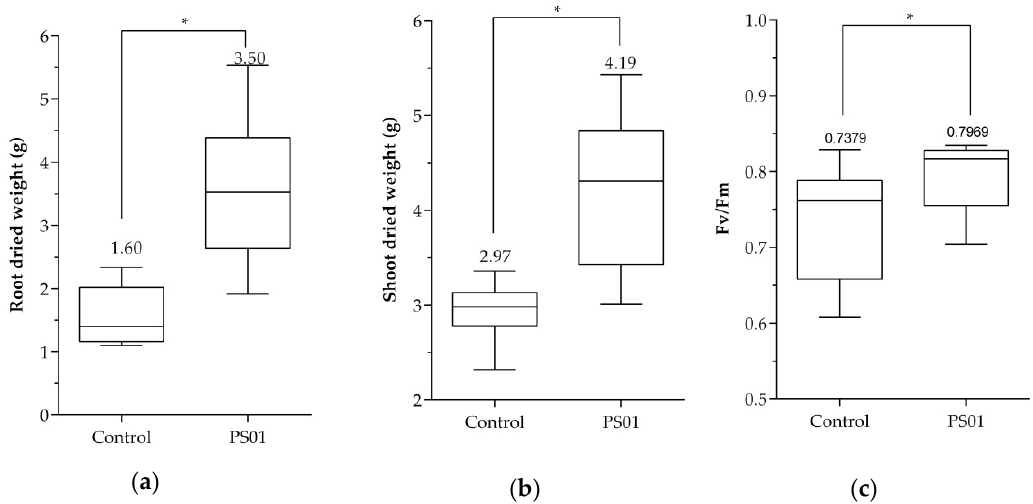
Figure 11. E ff ect of PS01 on growth of maize plant. PS01 improved ( a ) root dry weight; ( b ) shoot dry weight and ( c ) quantum e ffi ciency of photosystem II in maize plants after 30 days. Data are depicted as boxplots representing the range of values, the exclusive median. Asterisks indicate significant di ff erences (Student’s t test; p <